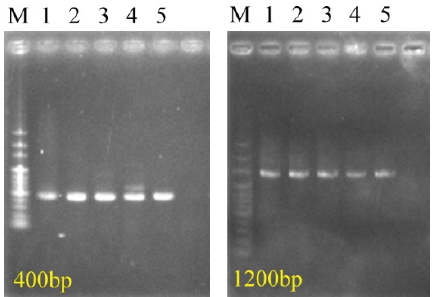
Figure 2. 16S rDNA from the Zuoying isolates amplified through PCR. M: Marker; Lanes 1, 2, 3, 4, and 5: ISZ1, ISZ2, ISZ3, ISZ4, and ISZ5, respectively.